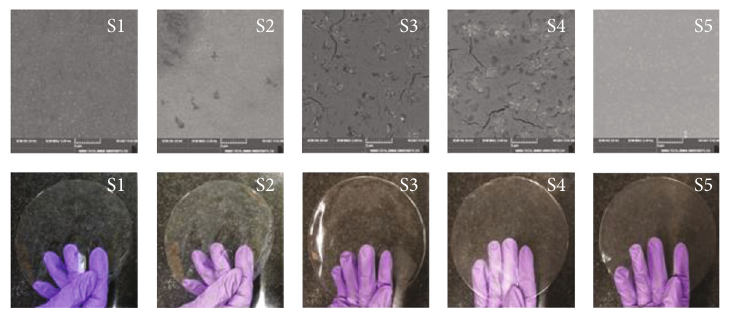
Figure 4: Scanning electron microscopy images of the samples (S1-100/0, S2-75/25, S3-50/50, S4-25/75, and